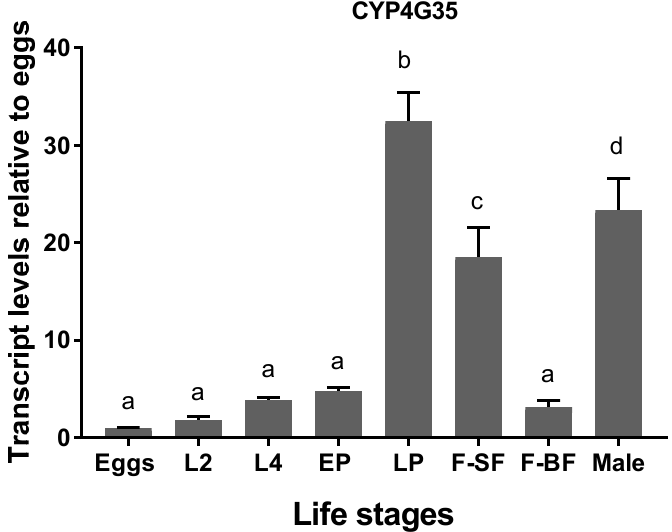
Figure 1. Transcript levels of CYP4G35 in Aedes aegypti life stages. qRT-PCR was used for relative transcript expression and 2 − ∆∆ Ct was used for analysis. Egg samples were used as a control for relative expression. The experiment was replicated three times with different biological cohorts of mosquitoes. One-way ANOVA was used with Tukey’s multiple comparison test. L2 = second instar larvae, L4 = fourth instar larvae, EP = early pupae (within 6 h of molt), LP = Late pupae (pharate adults), F-SF = sugar-fed female (24 h old), F-BF = blood-fed female (24 h post blood meal, 5 d old), Male (24 h old). N = 9. Mean ± SD. The letters above bars show statistical differences among samples.